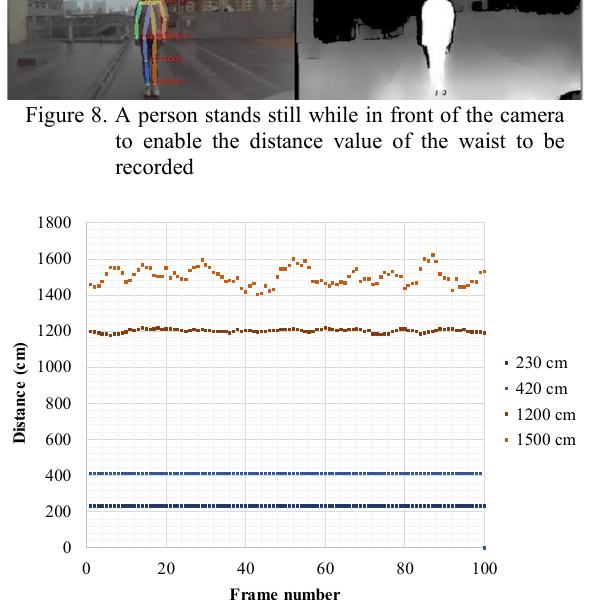
Figure 9. Accuracy assessment of the results from distance measurements of a person standing still at different distances in front of the camera